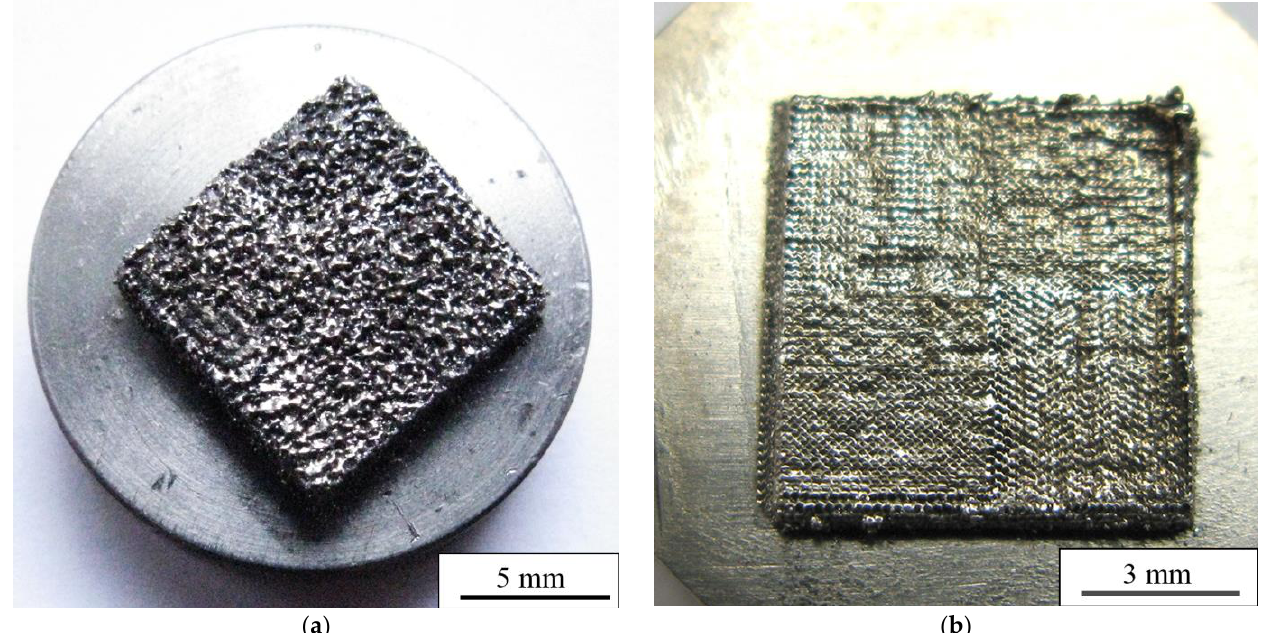
Figure 10. Top view of ( a ) porous and ( b ) dense LPBF-sample surface.